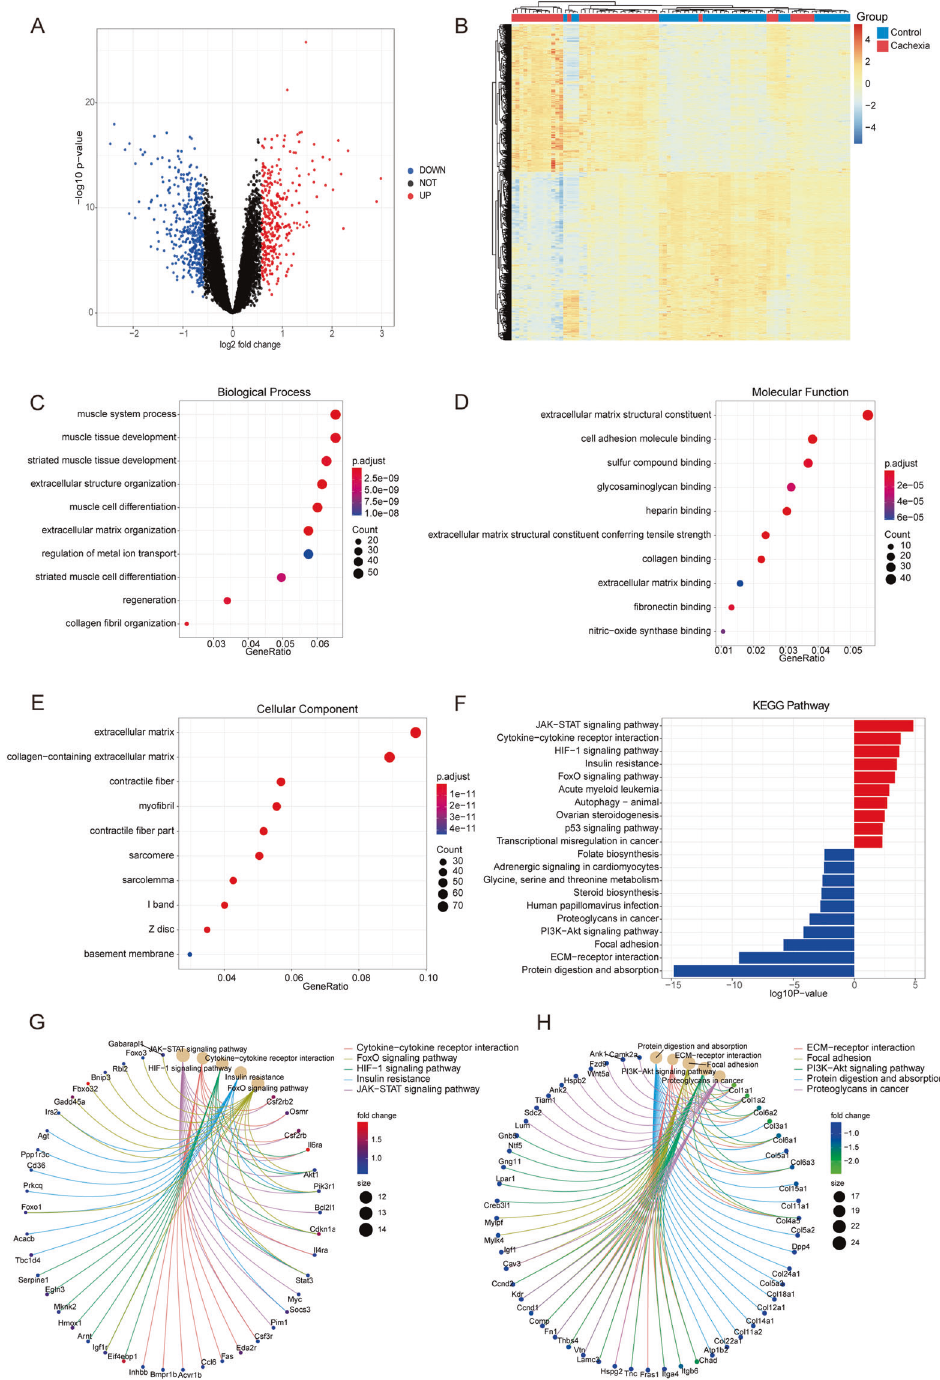
Fig. 4 Identi fi cation of DEGs and biological function enrichment analysis in the merged dataset. A Volcano plots of DEGs in the merged dataset. Red dots represent upregulated DEGs (371), and blue dots represent downregulated DEGs (422). B Heatmap of the DEGs showing a signi fi cant distinction between cachectic mice and control mice. C – E . GO enrichment analysis of DEGs in terms of biological process ( C ), molecular function ( D ), and cellular component ( E ) . F KEGG pathway mapping of DEGs. Red indicates upregulated pathways, blue indicates downregulated pathways. G , H . The circle map depicts the linkages of genes and KEGG pathways of upregulated ( G ) and downregulated ( H ) genes in cachectic muscle compared with control muscle. pro fi le of cachectic mice is distinct from that of control mice 0.05 and an absolute value of fold change > 1.5 were considered (Fig. 4B). as DEGs. The volcano plot showed the distribution of the DEGs The GO term enrichment analysis indicated the enrichment of according to the criteria; red dots represented upregulated DEGs extracellular matrix organization (GO: 0030198), extracellular (371), and blue dots represented downregulated DEGs (422) (Fig. structure organization (GO: 0043062), muscle system process 4A). The heatmap of the DEGs shows that the transcriptional Cell Death and Disease (2021)